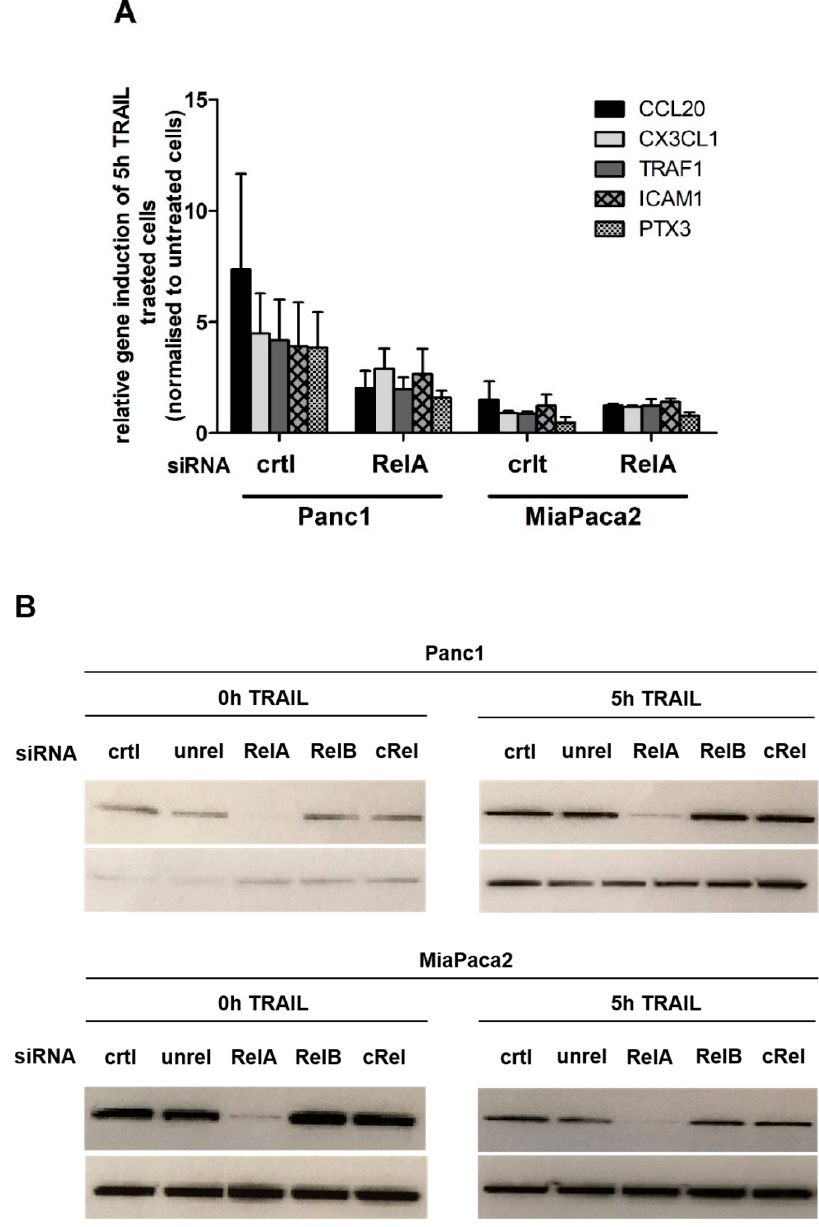
Figure 1. Top 5 upregulated TRAIL responsive genes in resistant PDAC cell lines. PDAC cells were transfected with the indicated siRNAs (unrel: unrelated control siRNA) for 48 h. Subsequent cells were left untreated or treated with 10 ng/mL TRAIL for 5h and a genome wide expression analysis ( A ) or western blot analysis ( B ) were performed. ( A ) Relative gene induction (5 h TRAIL treatment compared to untreated control siRNA cells) of the five strongest upregulated genes of the resistant cell line (Panc1) compared to the sensitive cell line (MiaPaca2) and the effect of transfection of the cells with RelA siRNA is shown. Mean of three independent replicates ± SD are shown; ( B ) Western bots whole cell lysates were analyzed using the p65/RelA antibody ( upper lane ) or Hsp90 antibody ( lower lane ) as control. One representative out of three is shown.